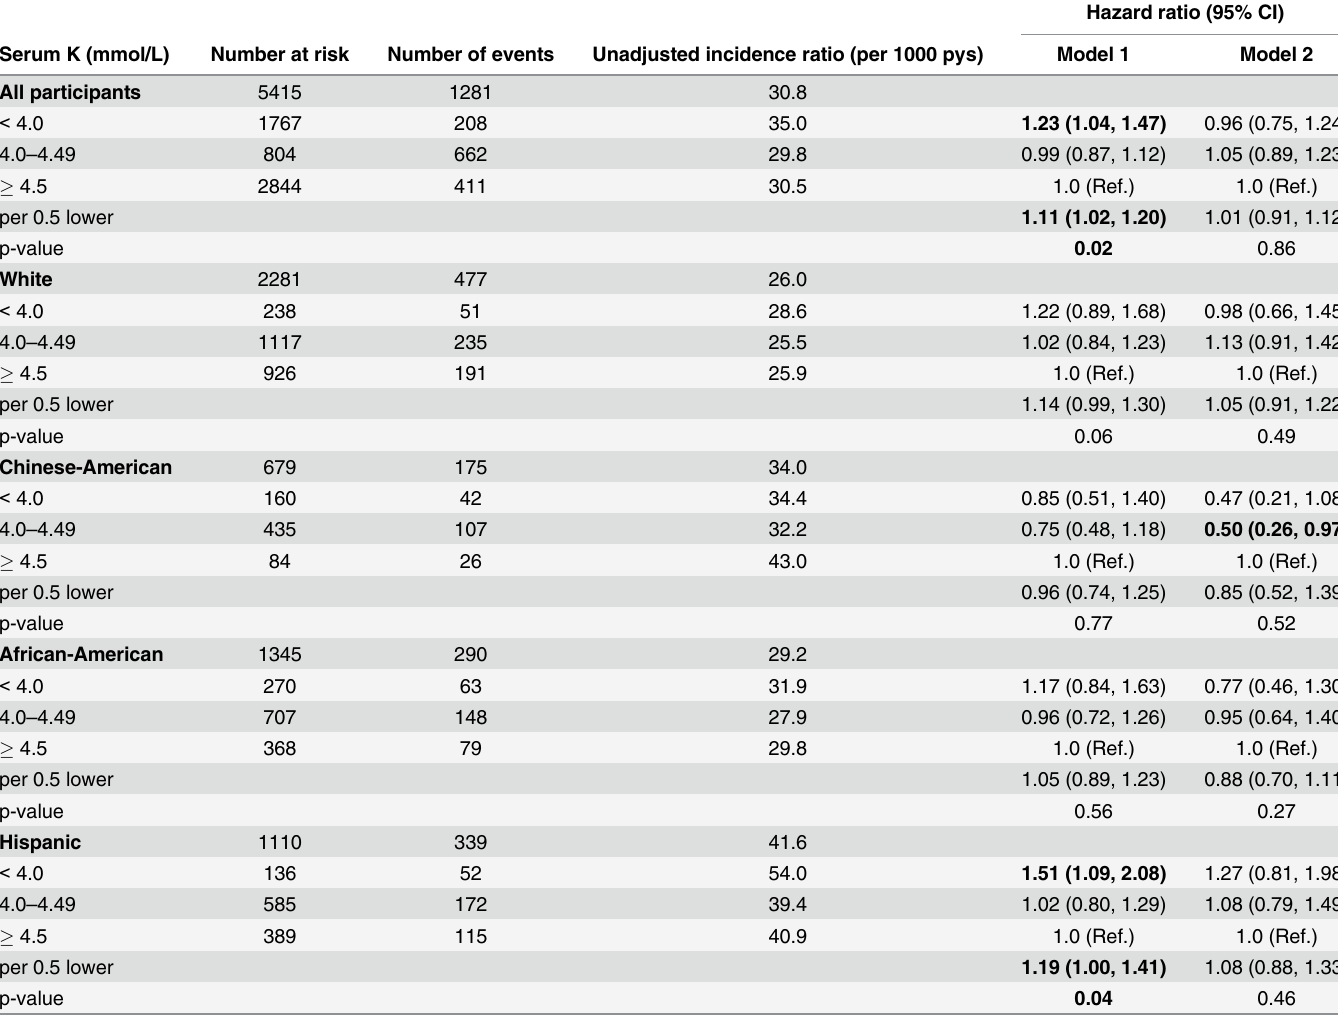
Table 3. Associations Between Serum Potassium and Incident Diabetes, by Ethnicity (N = 5415).